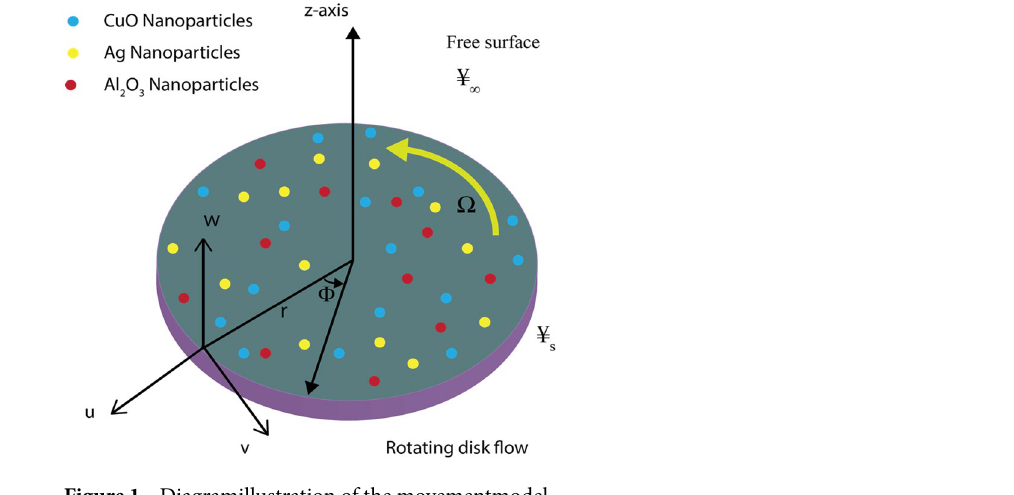
Figure 1. Diagramillustration of the